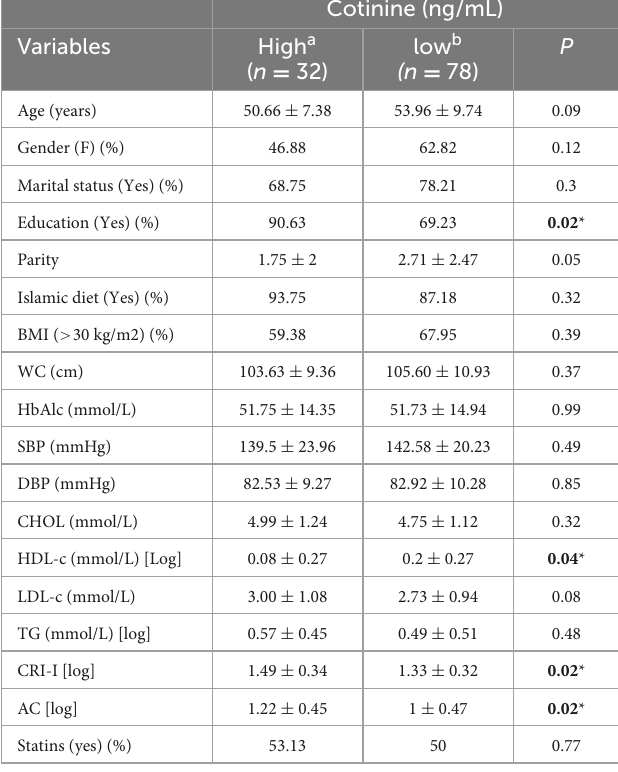
TABLE 1 Baseline characteristics of study participants by serum cotinine cutoff of ≥ 10